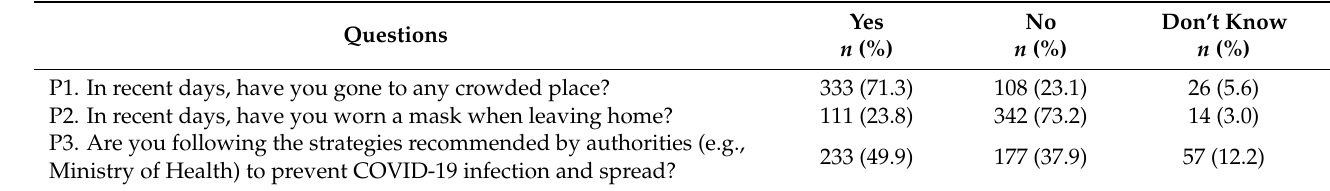
Table 6. Practices toward COVID-19 among